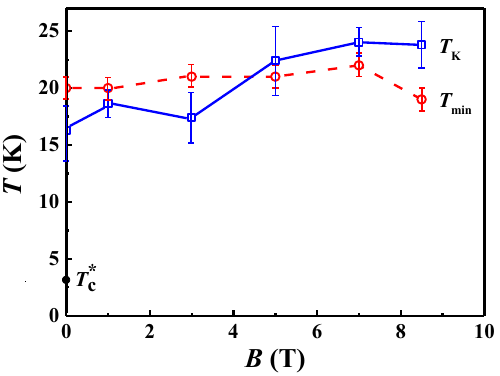
Figure 3. Characteristic temperatures vs. magnetic field B . T K is the extracted Kondo temperature from Fig. 2 using the Hamann theory. T min is the temperature where the resistance vs. temperature curve has a minimum, T ∗ c is the zero-field onset temperature for superconductivity. All are deduced from Fig. 2c.